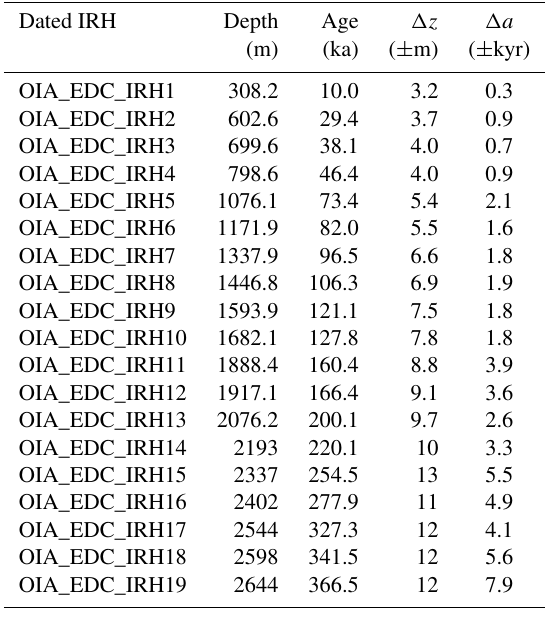
Figure 4. Zoomed-in view of radar transect intersections between different radar systems: (a) between the HiCARS OIA transect OIA/JKB2n/Y77a and the DELORES transect 2H30E-H30B (both marked in Fig. 1) and (b) between the HiCARS OIA transect OIA/JKB2n/Y77a and the MCoRDS transect 20121227_01 (red line in Fig. 1). The traced IRHs are highlighted by red circles ei- ther side of the crossover point (marked by a red vertical line). The vertical scale is the true vertical depth (TVD) in meters. Note that in this color map, IRHs (maximum amplitudes in radar returns) are displayed in white.